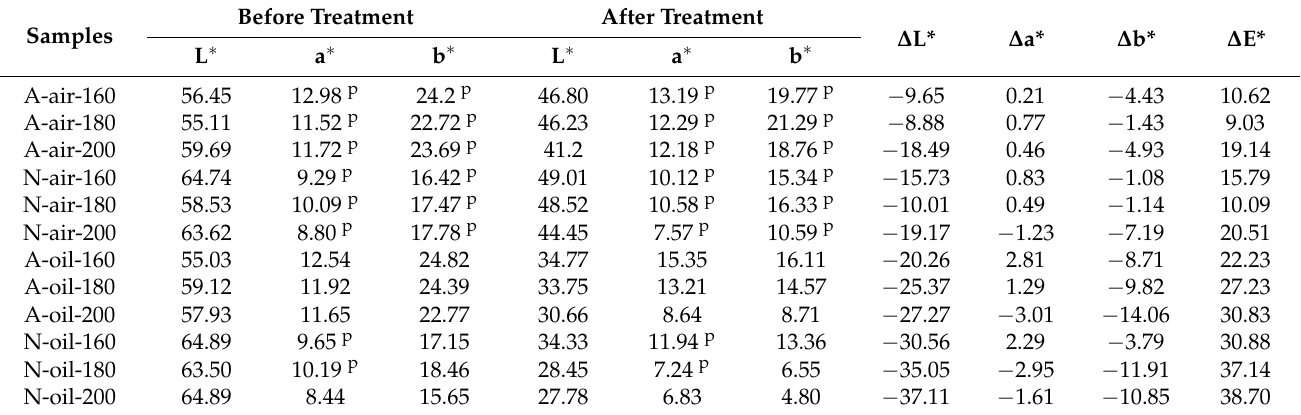
Table 2. The influence of heat treatment under air or palm oil on Afrormosia and Newtonia color.